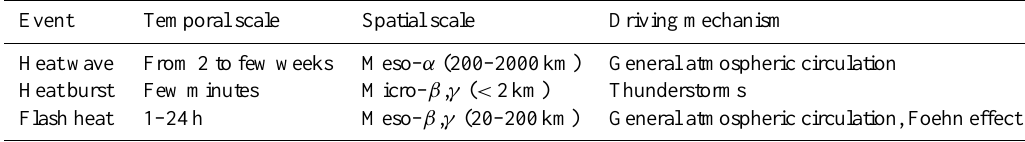
Table 1. Three different scales of events linked to abnormally high temperatures. The scales are adapted from Orlanski (1975).